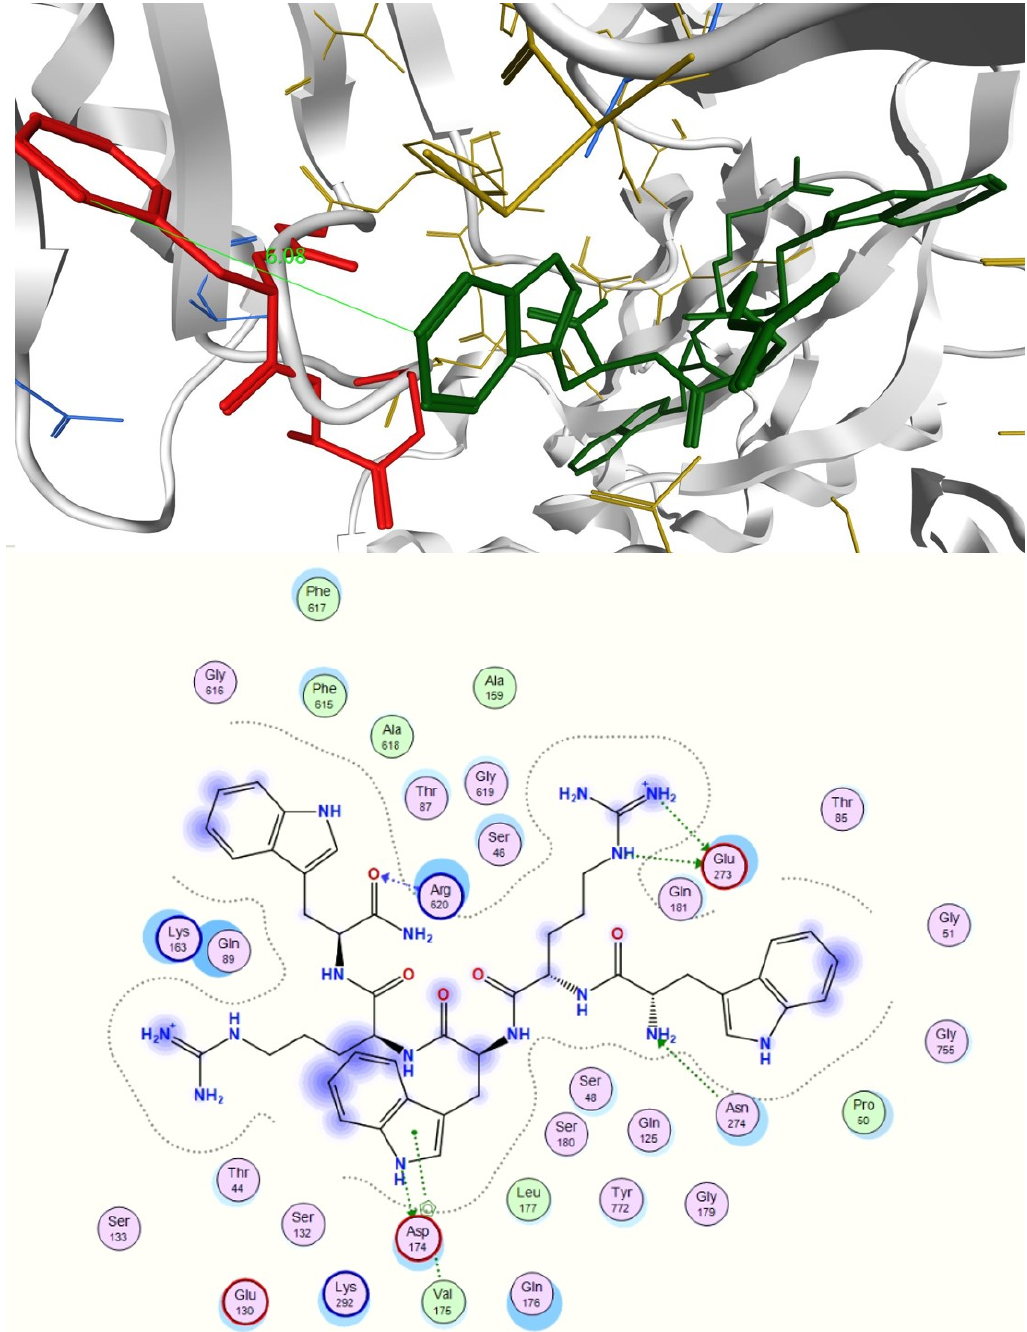
Figure 9. The most favorable pose of potentiating peptide 6 , WRWRW-NH 2 (green) located in the distal binding pocket (yellow). The peptide interacts strongly with the loop (red) and in particular Trp6 forms a hydrophobic interaction with Phe617. The proximal binding pocket is shown in blue.